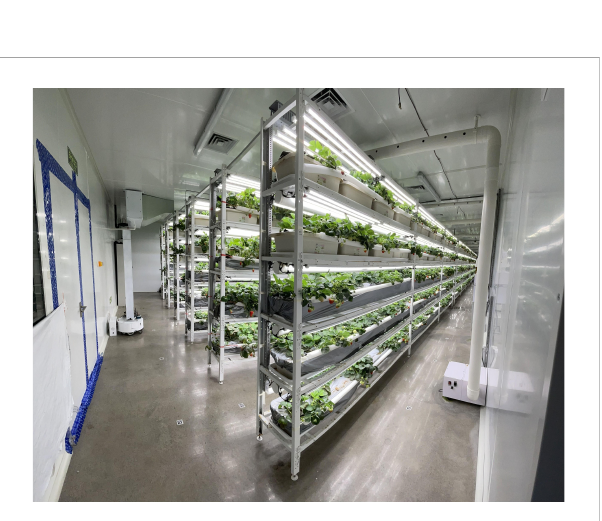
FIGURE 3 The MRP is being charged in the commercial strawberry